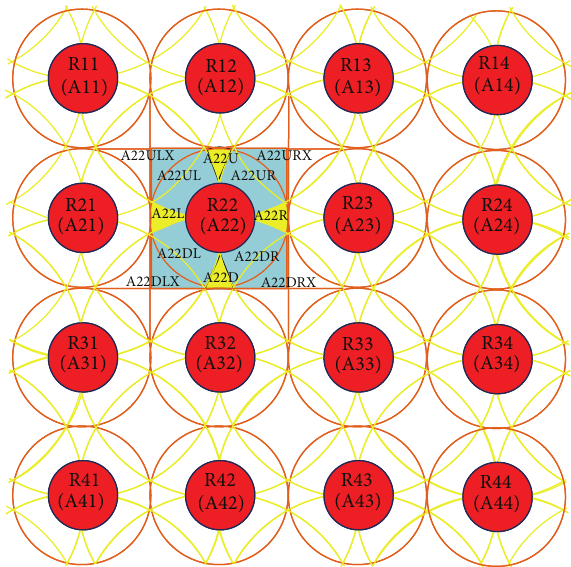
Figure 3: The schematic diagram of partitioned sections.